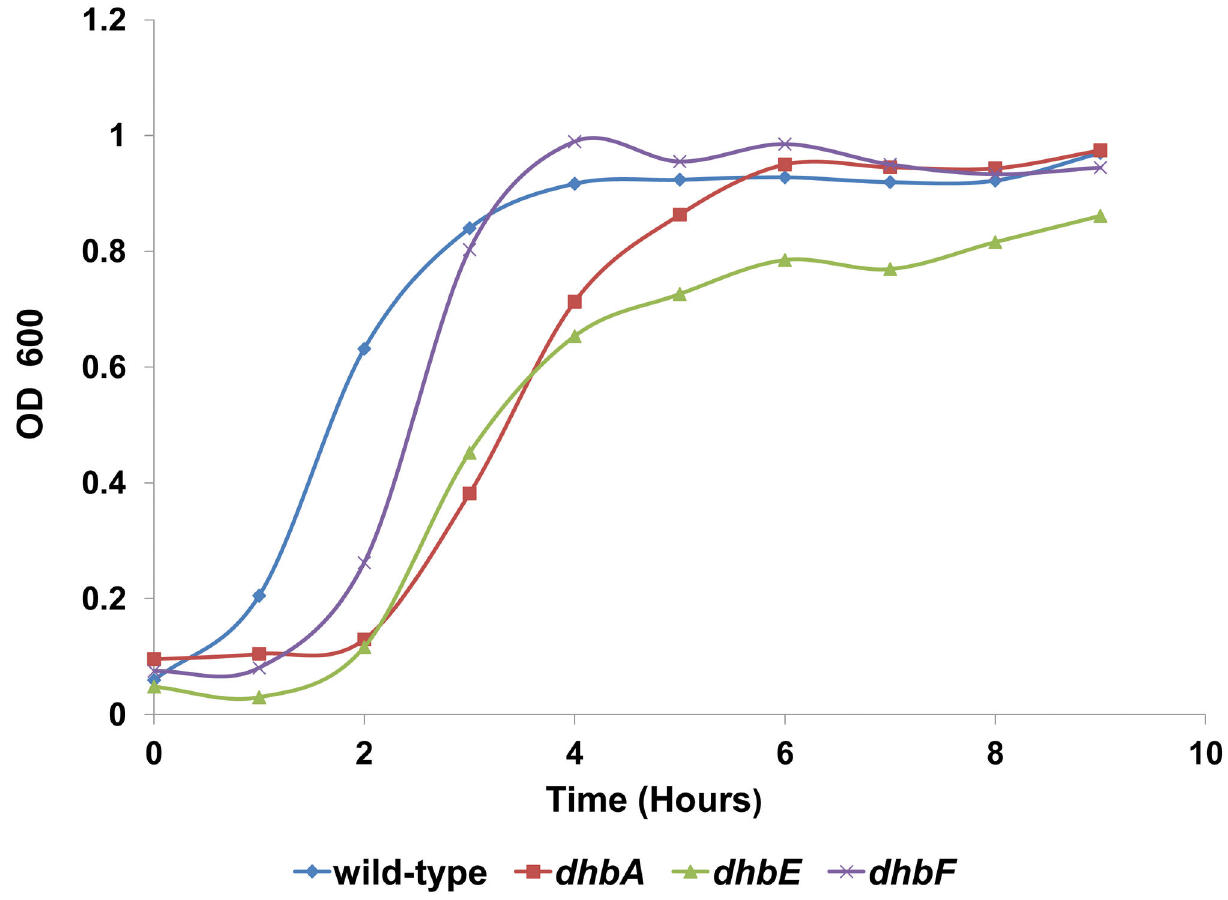
Figure 7. Growth curves of B. subtilis 3610 wild-type and dhb mutants. Growth curves were performed in spreading medium. The presented results are representative of three independent